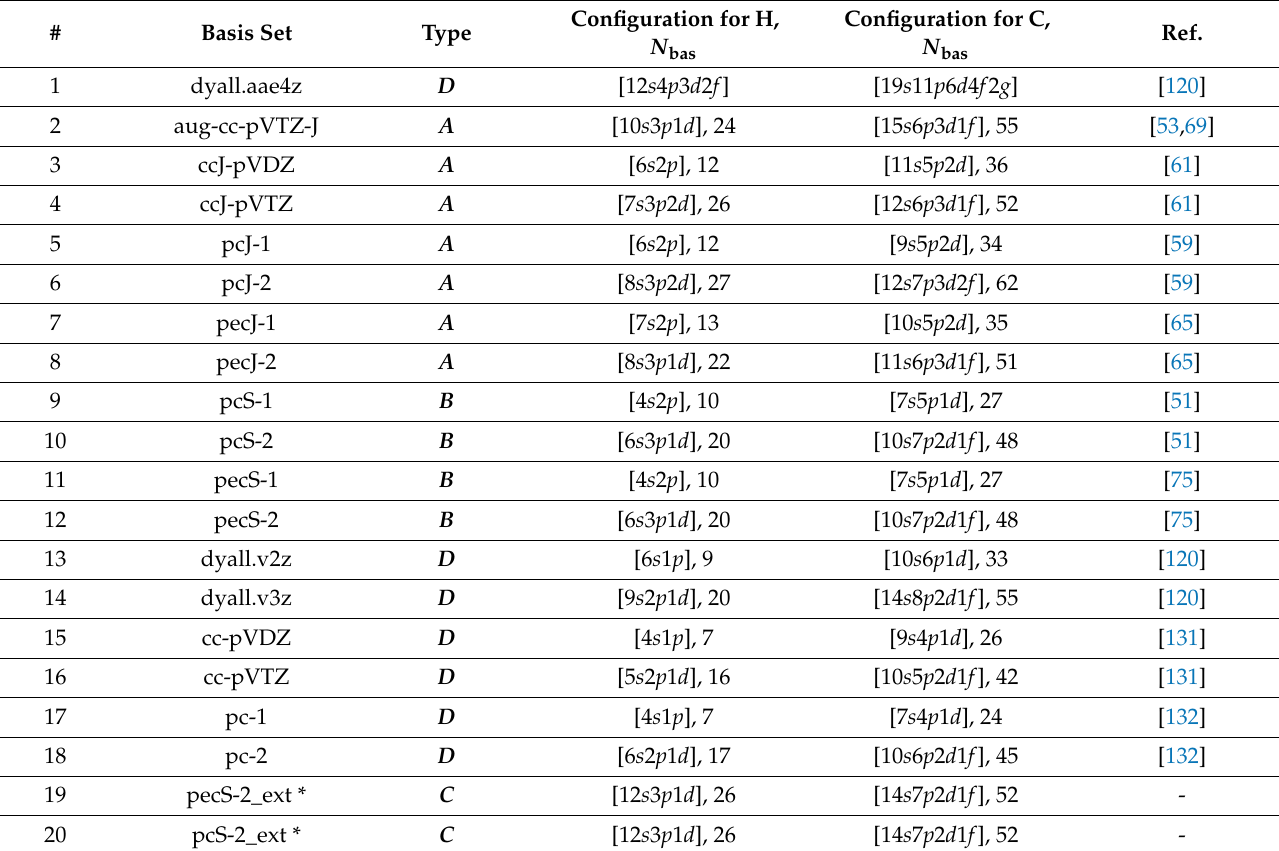
Table 2. Basis sets used for testing. Types of basis sets: A —specialized J -oriented; B —specialized σ -oriented; C — σ -oriented extended in a tight s -region; D —nonspecialized,